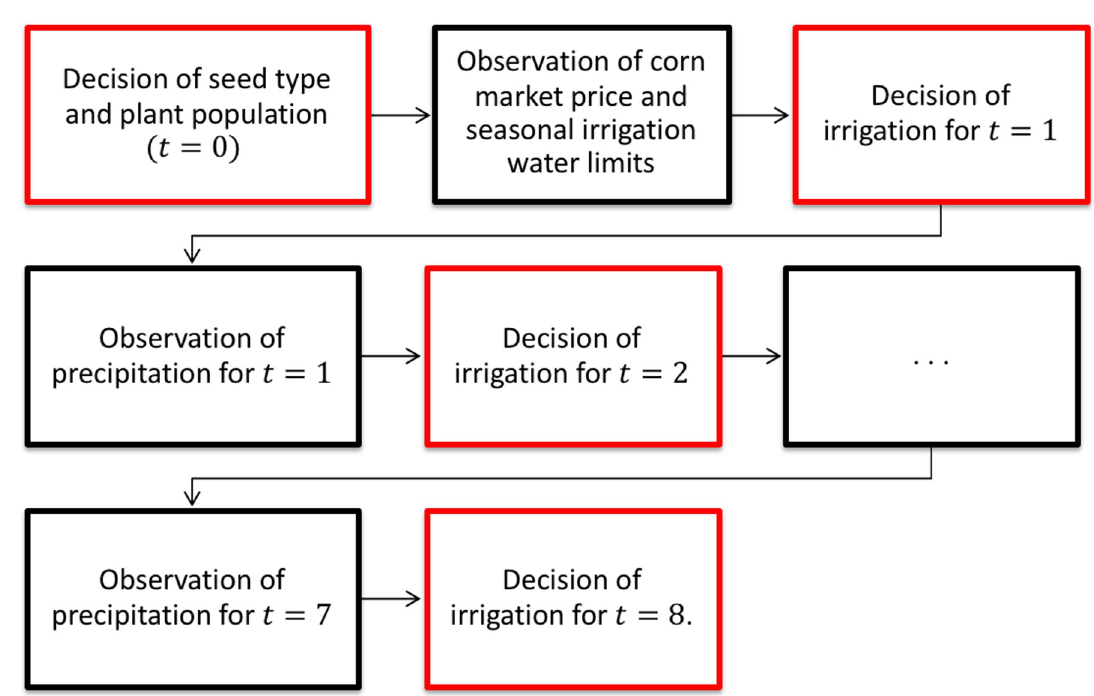
Fig 1. The detailed decision process for multistage stochastic